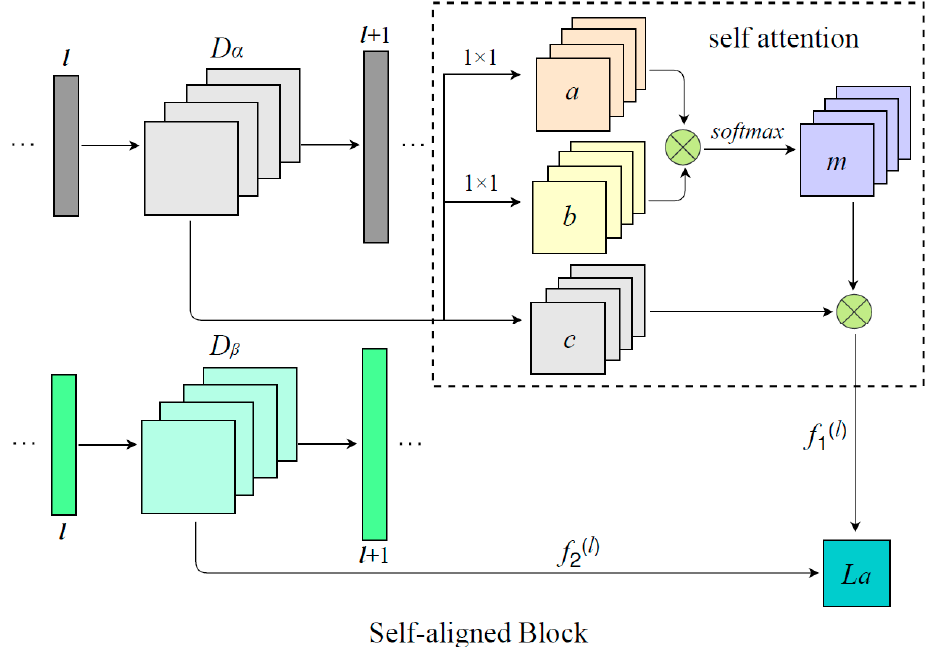
Figure 3. The architecture of the self-aligned block. The rectangle stands for residual block in D α and D β . The square stands for the feature maps. α and β stand for the two different domains. Images from the domain β are the images to be aligned.